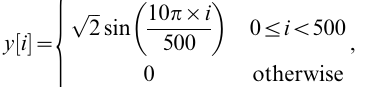
Figure 1. verifies the correctness of the mean of PRVCC under CGM (4) for large samples and small e . Specifically, in Figure 1. we plot the simulation results (circles) and the theoretical results of (21) (solid lines), and the contamination-free version (49) (dashed lines) under different combinations of r ’ [ f { 1,0,1 g and